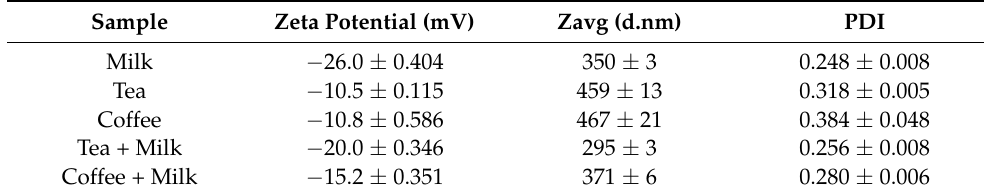
Table 2. Effect of milk addition on the zeta potential and Zavg (d.nm) of tea and coffee extracts.